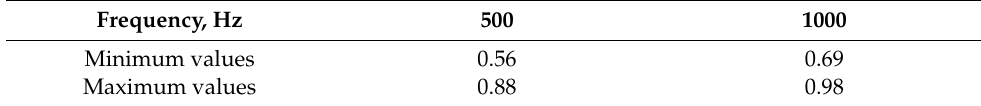
Table 7. Audience absorption coefficients (mid frequencies).